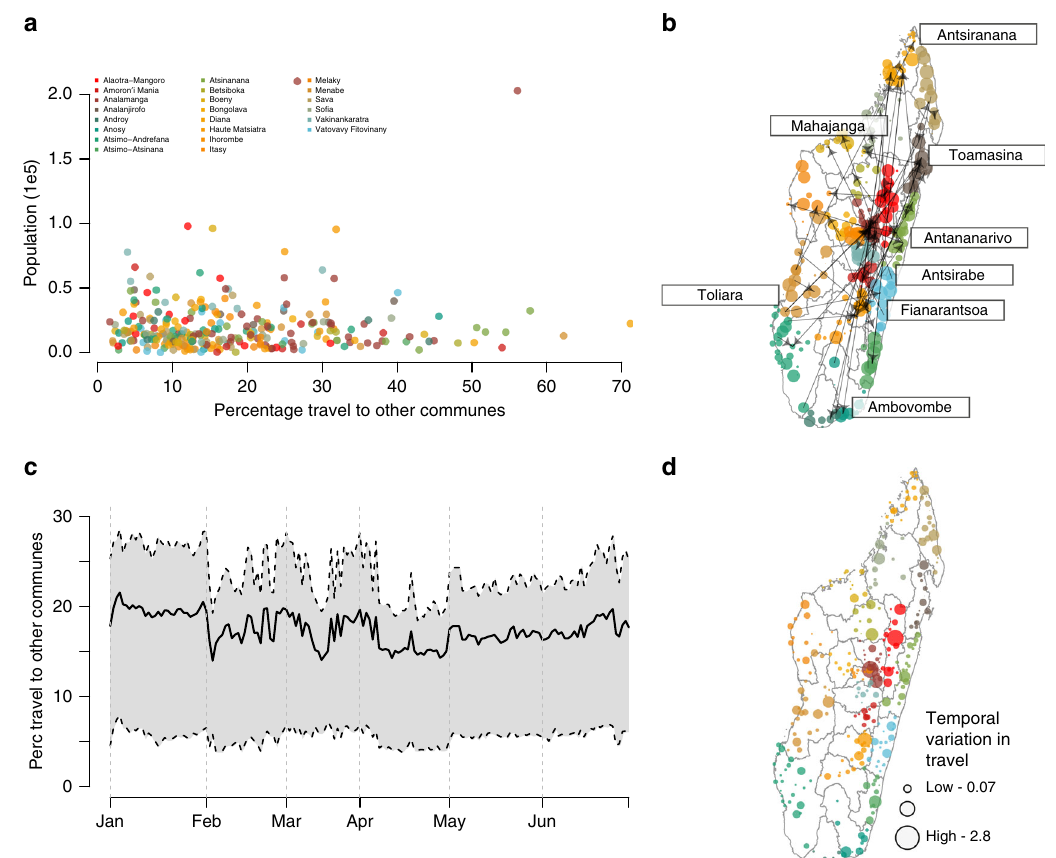
Fig. 2 The mobility patterns in Madagascar. We quanti fi ed trips between communes (~59,000 routes between 367 communes) in Madagascar using mobile phone data (see “ Methods ” section). a The percentage of trips to other communes versus the population size is shown for communes colored by region. In the majority of districts, few trips were to other communes and the percentage was not biased spatially or by population. b The top quantile of trips between communes are shown as directed arrows, with colors for regions as in the previous fi gure. The majority of trips involved a major population center (labeled) including the central capital (Antananarivo). c Travel between communes was fairly consistent over the time series with dips in early February, mid-March, and April. d The coef fi cient of variation in the amount of travel originating from each commune showing that the largest areas are also most